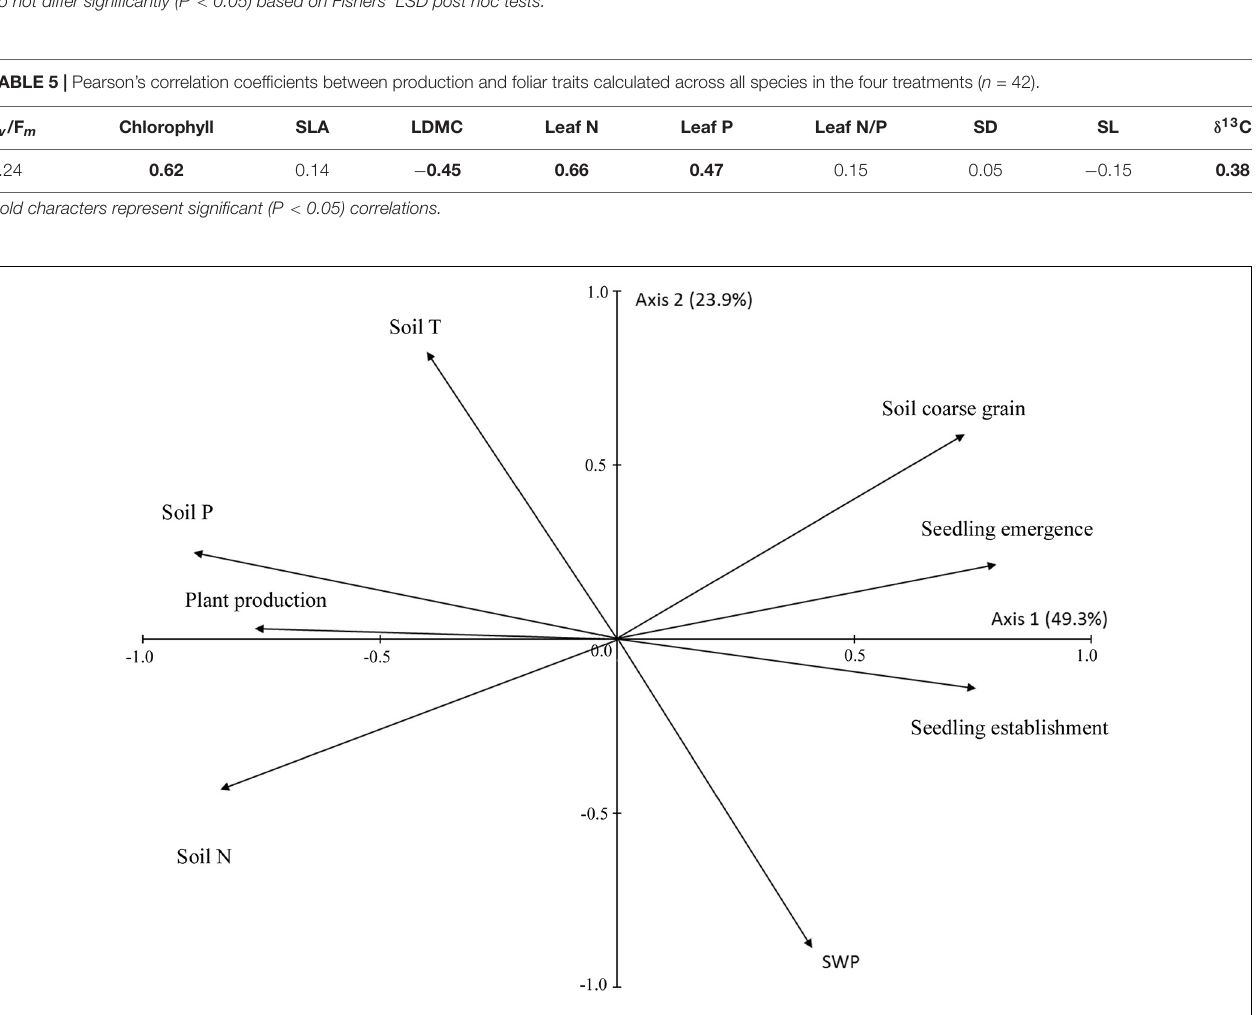
Whenever the main effect of treatment was significant, differences between mean values are indicated by letter. Within each row, the means followed by the same letter do not differ significantly (P < 0.05) based on Fishers’ LSD post hoc tests.